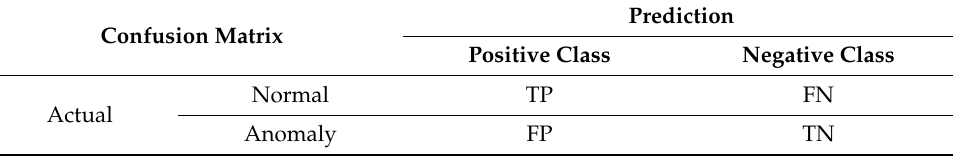
Table 2. Confusion